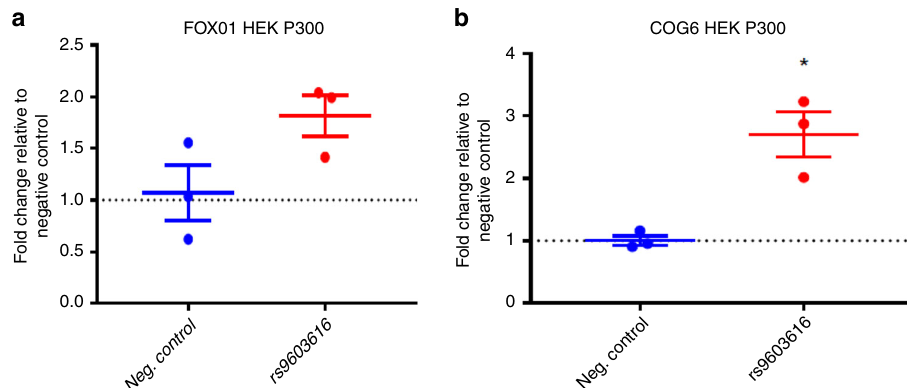
Fig. 7 CRISPR dCAS9 activation (CRISPRa) targeting of an RA-associated variant. The region around an associated RA variant (rs9603616) on chromosome 13 intronic of the COG6 gene was targeted in the HEK2937T cell line, using p300 as the activator. a Fold change (qPCR) effect on FOXO1 gene expression compared to negative control. b Fold change (qPCR) effect on COG6 gene expression compared to negative